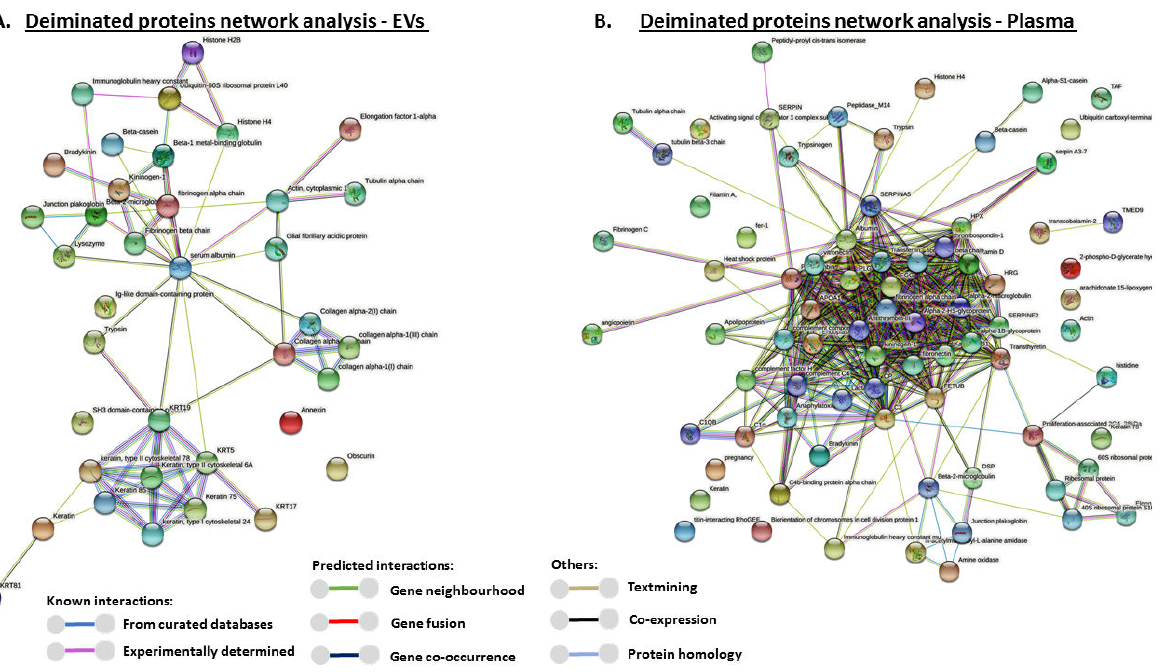
Figure 5. Protein–protein interaction networks of deiminated proteins identified in reindeer plasma EVs and in whole plasma. Protein–protein interaction networks for deiminated proteins in reindeer plasma EVs and whole plasma, based on known and predicted interactions in Bos Taurus as a representative species for Artiodactyla, using Searching Tool for the Retrieval of Interacting Genes/Proteins (STRING) analysis. PPI enrichment p -value for both networks is p < 1.0 × 10 − 16 . ( A ) Protein networks enriched in deiminated proteins in reindeer plasma EVs; colored nodes represent query proteins only. ( B ) Protein networks enriched in deiminated proteins in reindeer whole plasma; colored notes represent query proteins only. Colored lines connecting the nodes show the type of interactions between the nodes in the networks; this is based on known interactions, predicted interactions and other (including textmining, co-expression and protein homology); the color code is provided in the